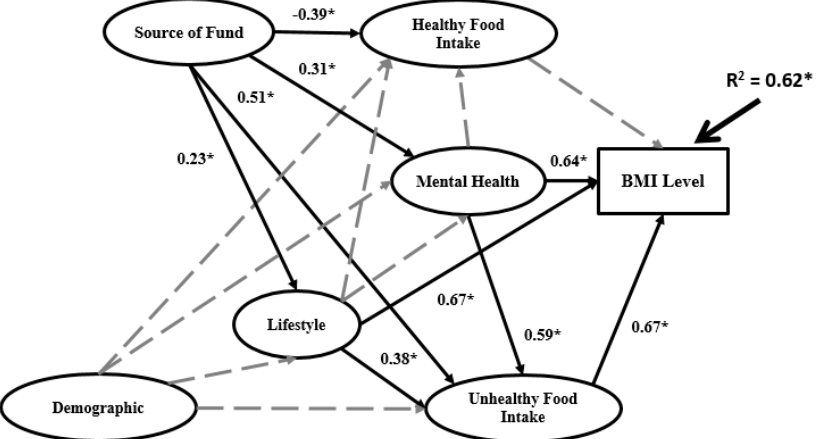
Figure 5. Final BSEM outputs of the Bachelor model.